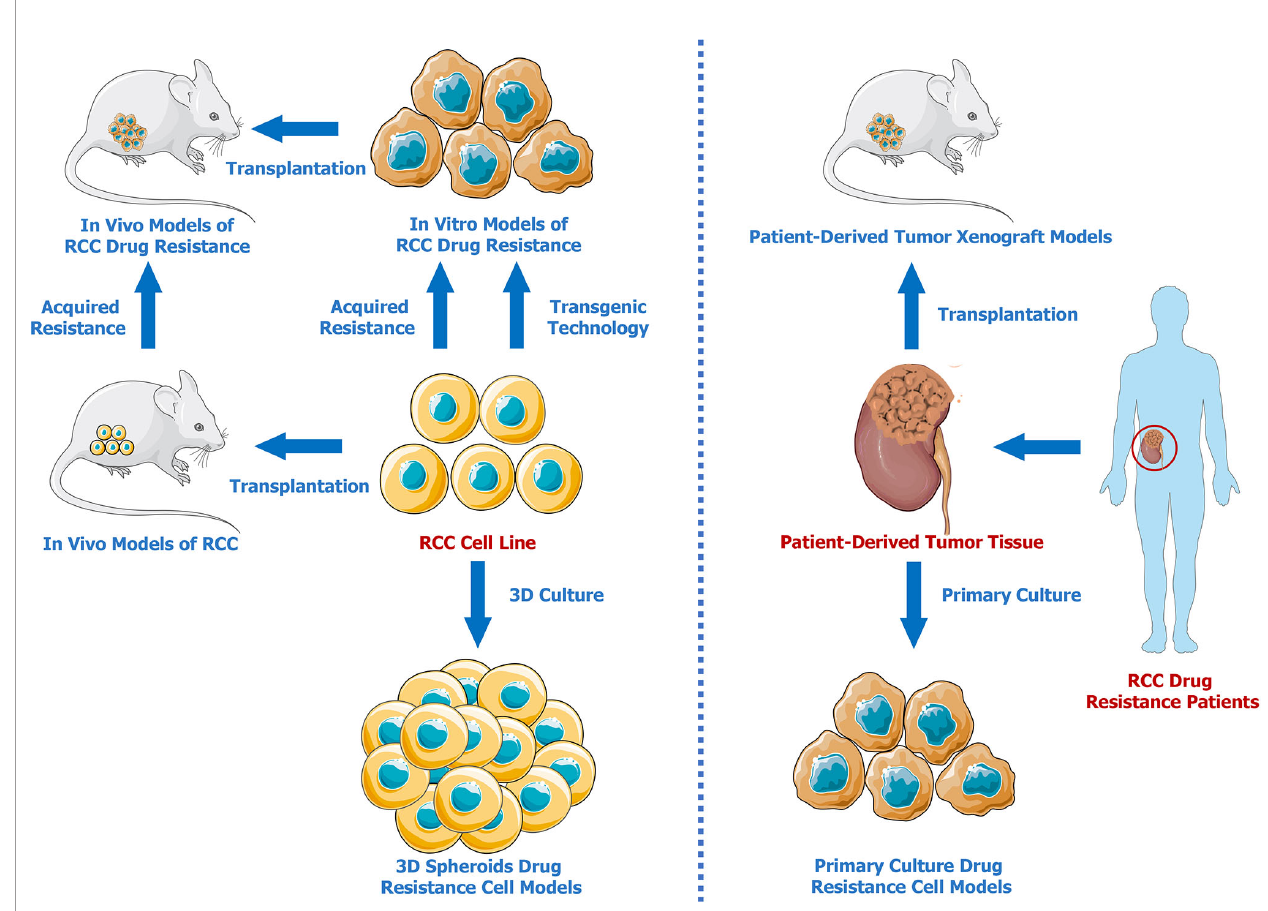
FIGURE 1 | Renal Cell Carcinoma Drug Resistance